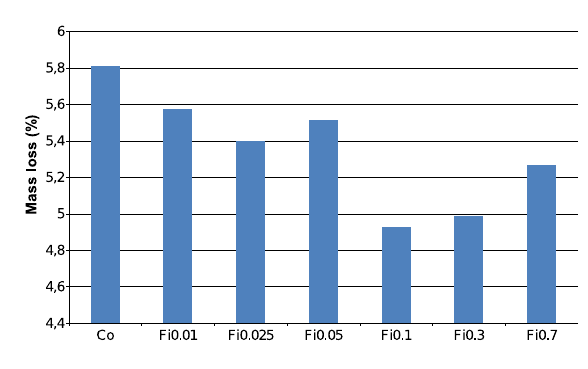
Figure 6. Moisture loss from mixes.